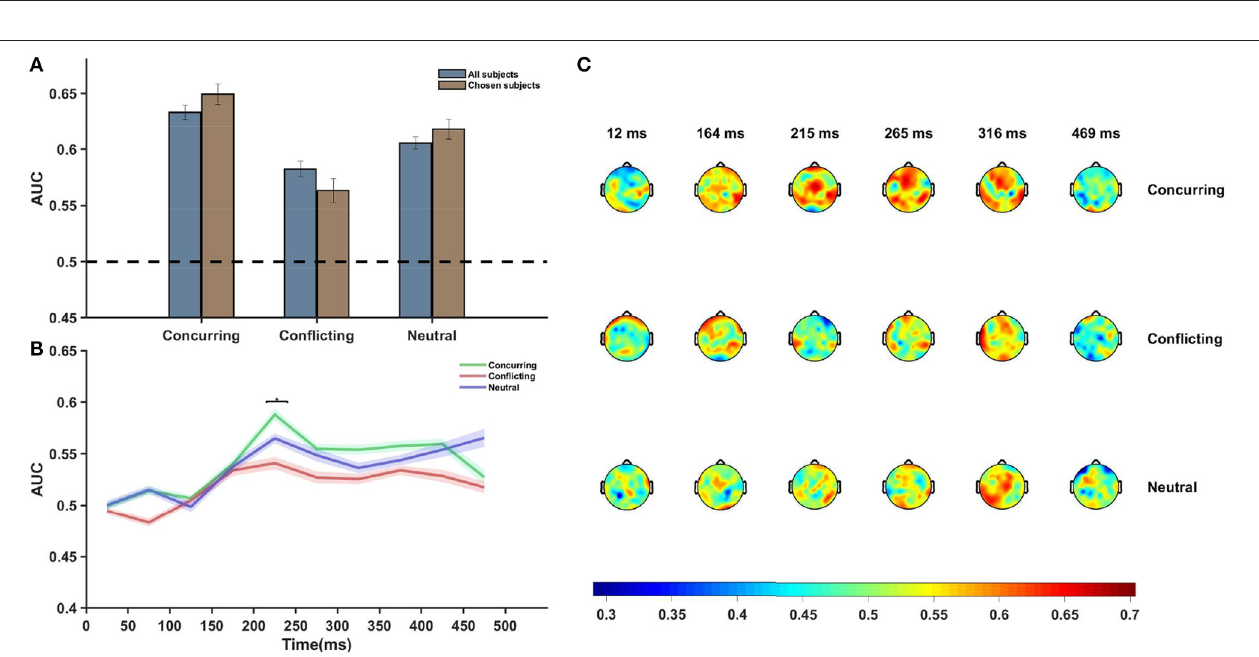
FIGURE 4 | Neural data analysis. (A) Figure shows average AUC predicting choice probability with single-trial EEG analysis and using multivariate pattern analysis. Average AUC increases under the influence of concurring cues and decreases under the influence of conflicting cues as compared to that for neutral cues in all subjects. The effect is more prominent in case of the chosen subjects. Error Bars indicate SEM. (B) Plot of average AUC across all subjects at different time points. ± The increase in AUC is most pronounced in the 200–300 ms post-stimulus interval. The difference between the AUCs of concurring and conflicting trials is most significant ( p 0.054, FDR corrected) in the 200–250 ms window (marked using *). (C) Topoplot of one subject showing per electrode per time window single trial = classification under different cue conditions. Average AUCs of the all channels for successive time windows are shown. There appears to be a significant involvement of the frontal and occipital electrodes 200–350 ms post-stimulus onset. Color bar depicts the value of AUC.